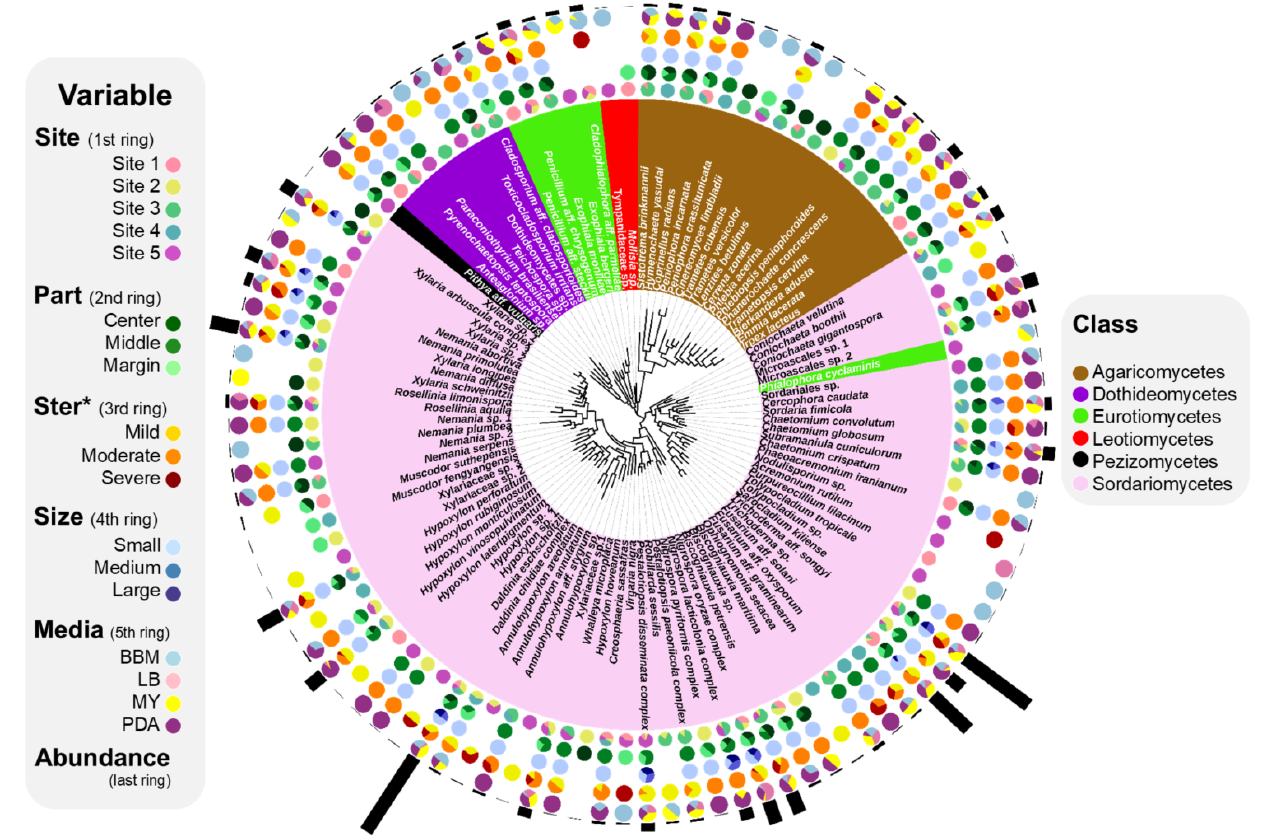
Figure 3. Phylogenetic relationships of the isolated ELF and relative abundances of classes in ELF communities isolated from different lichen thalli, different parts of lichen thallus, after different regimes of thallus surface sterilization, from fragments of different sizes and on different types of medium. Ster*, Sterilization.